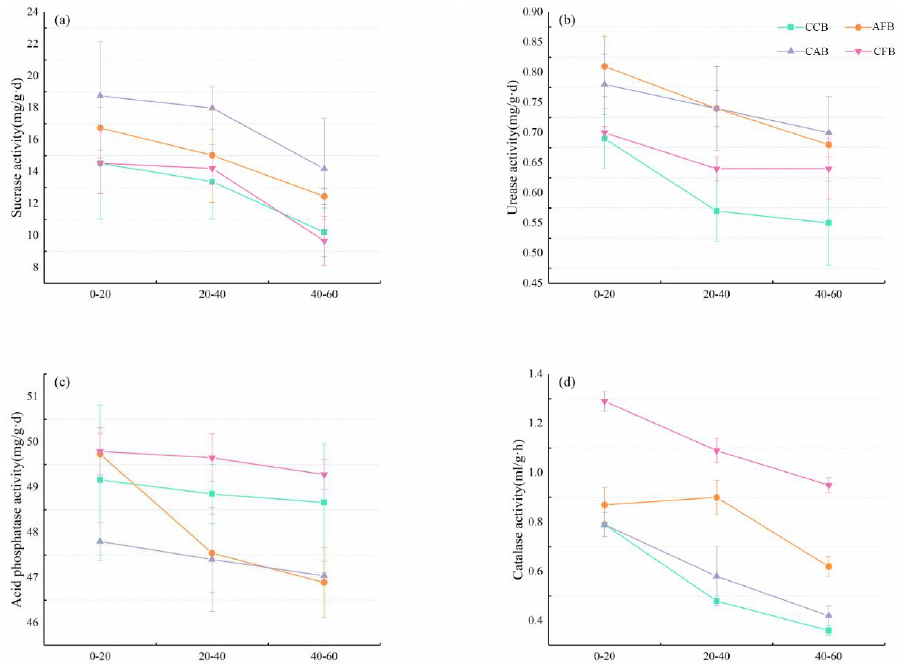
Figure 4. ( a ) Sucrase activity, ( b ) urease activity, ( c ) acid phosphatase activity and ( d ) catalase activity in mixed forest of different bamboo and broad-leaved